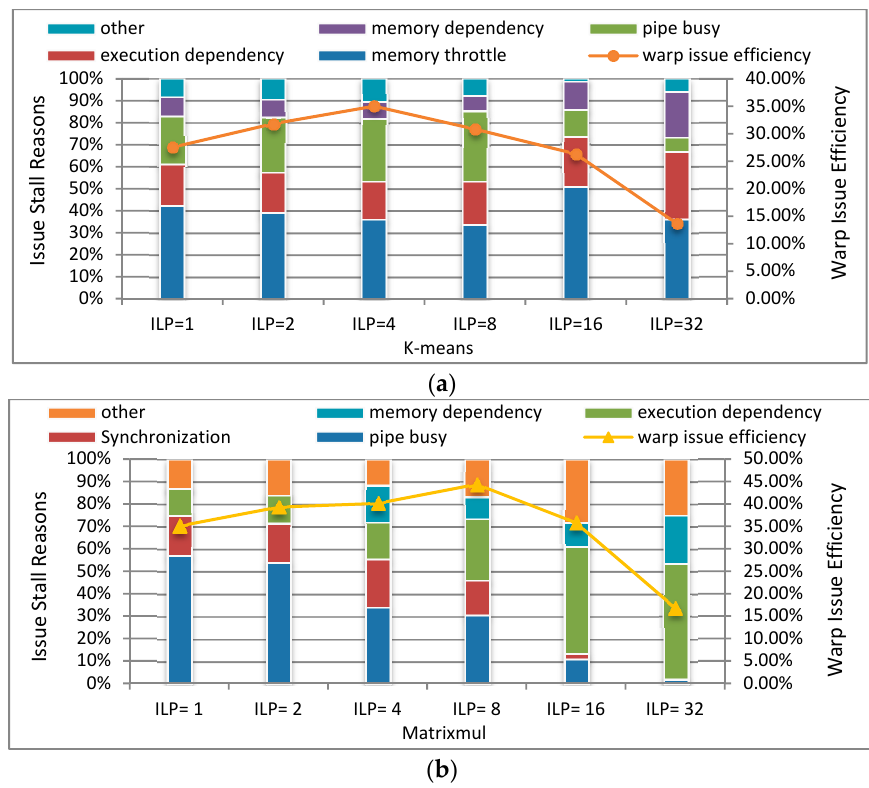
Figure 13. Warp issue efficiency and warp issue stall reasons: ( a ) KM warp stall reasons; ( b ) MM warp stall reasons.